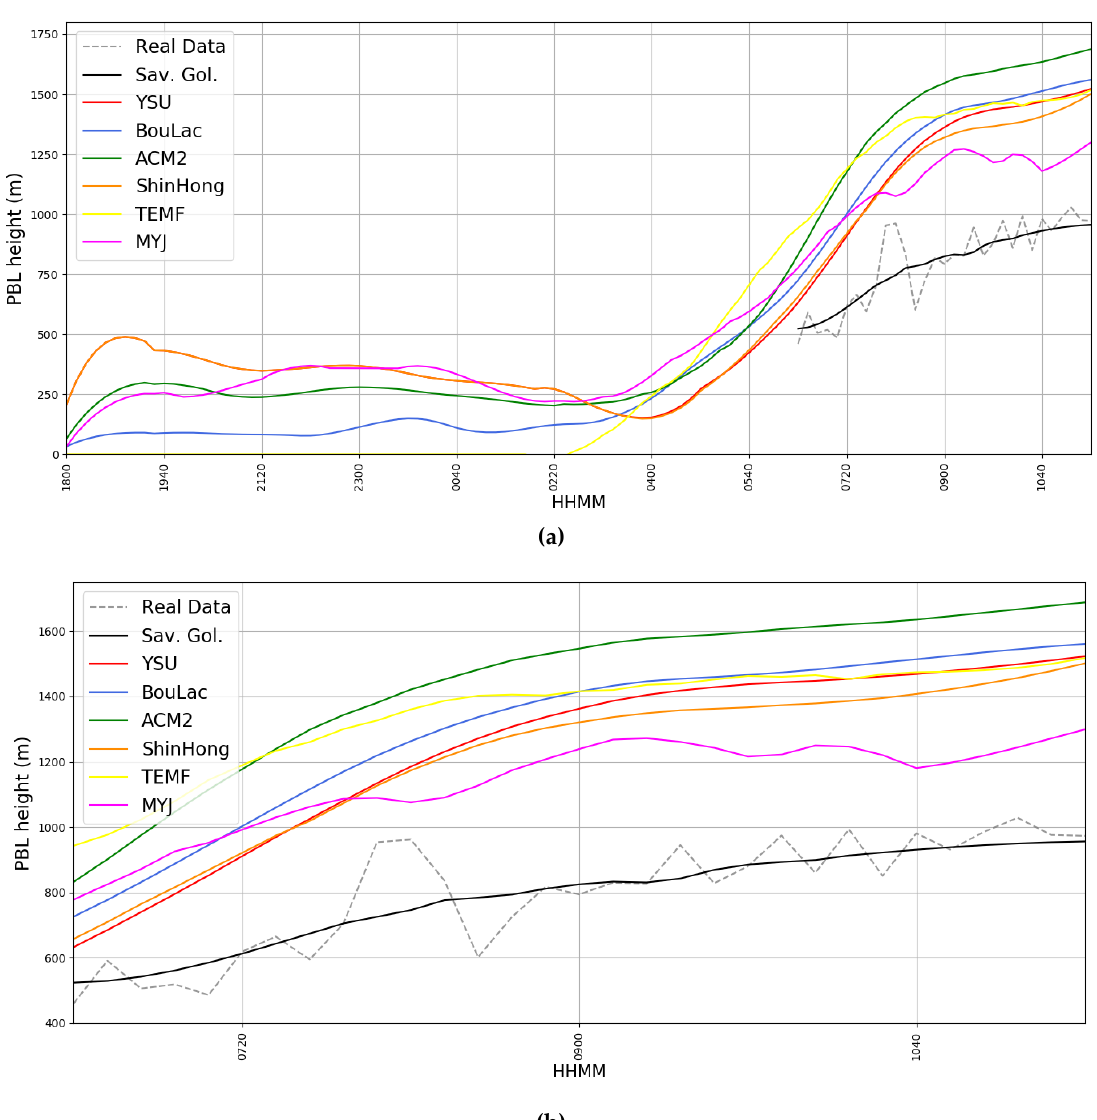
Figure 8. ( a ) Simulated PBLH timeseries compared with lidar-retrieved PBLH timeseries, 17 / 05 / 2017, dotted grey: real data, black: Savitsky–Golay smoothing of real data, red: simulated data with YSU parametrization, blue: simulated data with BouLac parametrization, green: simulated data with ACM2 parametrization, orange: simulated data with ShinHong parametrization, yellow: simulated data with TEMF parametrization, purple: simulated data with MYJ parametrization. ( b ) Simulated PBLH timeseries compared with lidar-retrieved PBLH timeseries, zoomed-in, 17 / 05 / 2017, dotted grey: real data, black: Savitsky–Golay smoothing of real data, red: simulated data with YSU parametrization, blue: simulated data with BouLac parametrization, green: simulated data with ACM2 parametrization, orange: simulated data with ShinHong parametrization, yellow: simulated data with TEMF parametrization, purple: simulated data with MYJ parametrization.